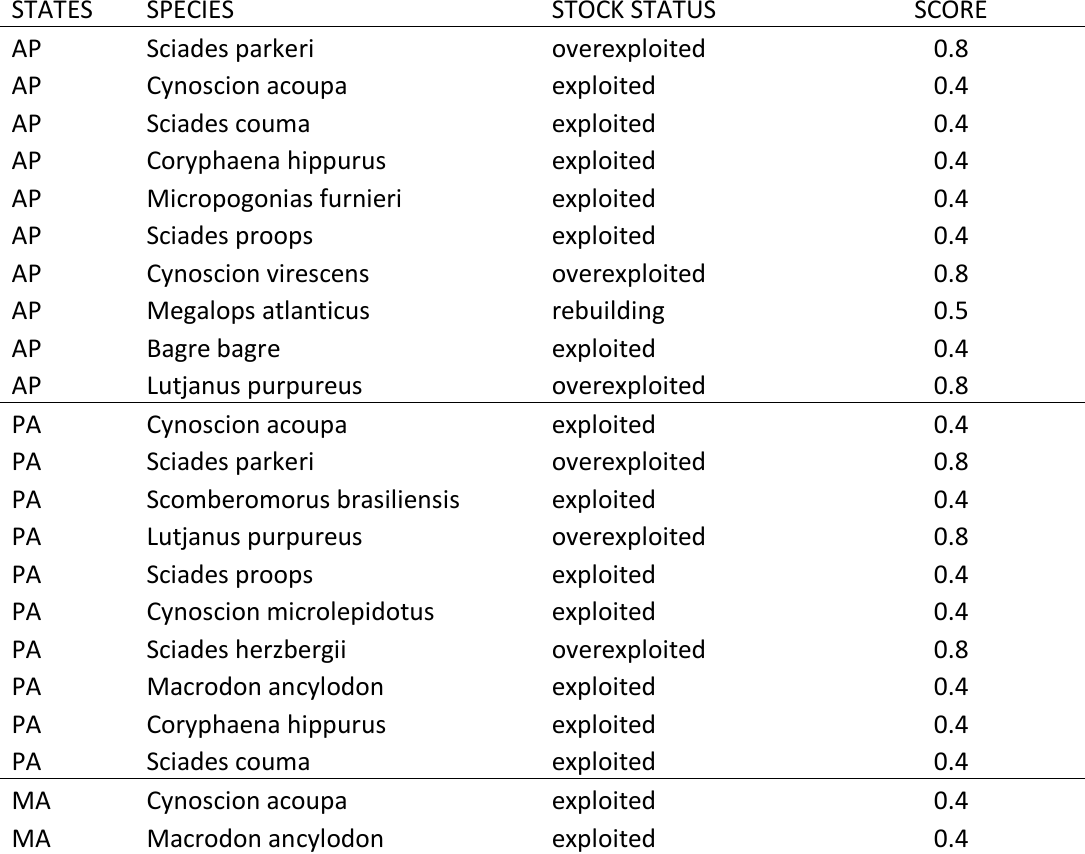
Table A6.1: Stock status assessment of the 10 fish species caught along the Brazilian coastline by artisanal and industrial sectors. *These were not identified at the species level, so we used the average value of the categories for the two more frequent species in that